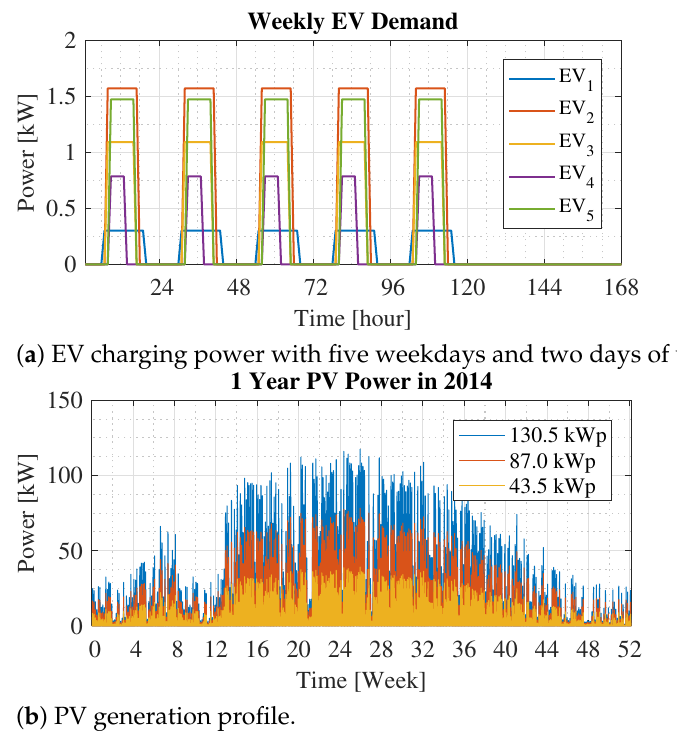
Figure 3. Typical EV and PV power profiles for office